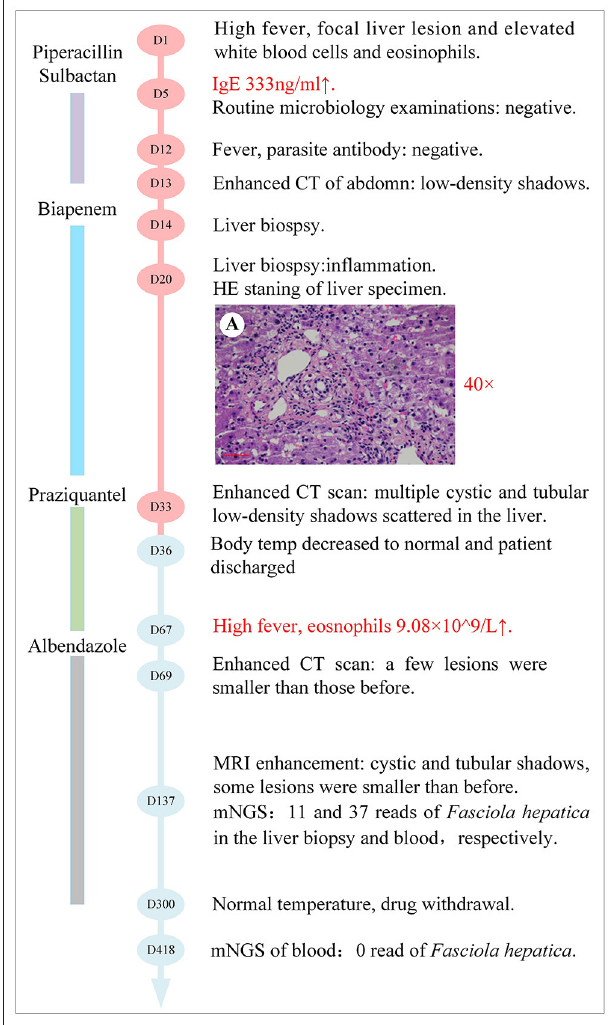
FIGURE 1 | The clinical course of the patient (schematic). Hematoxylin and eosin staining of the liver specimen shows some punctate necrosis on the lobule, apoptotic bodies in the hepatic cord, fatty degeneration of hepatocytes, mild inflammation in the portal area, and eosinophil infiltration in the inflammatory necrosis